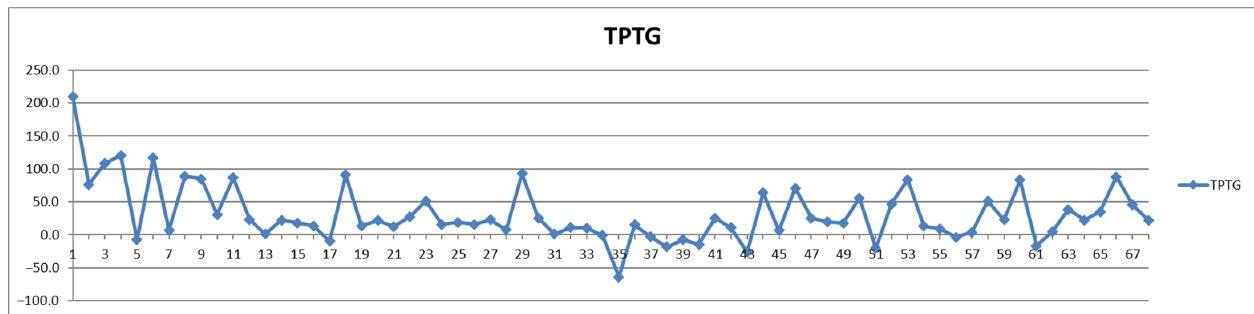
Figure 13. The food intake effect on total triglycerides (TPTG) as difference between postprandial and fasting concentrations as percentage relative to fasting concentration.